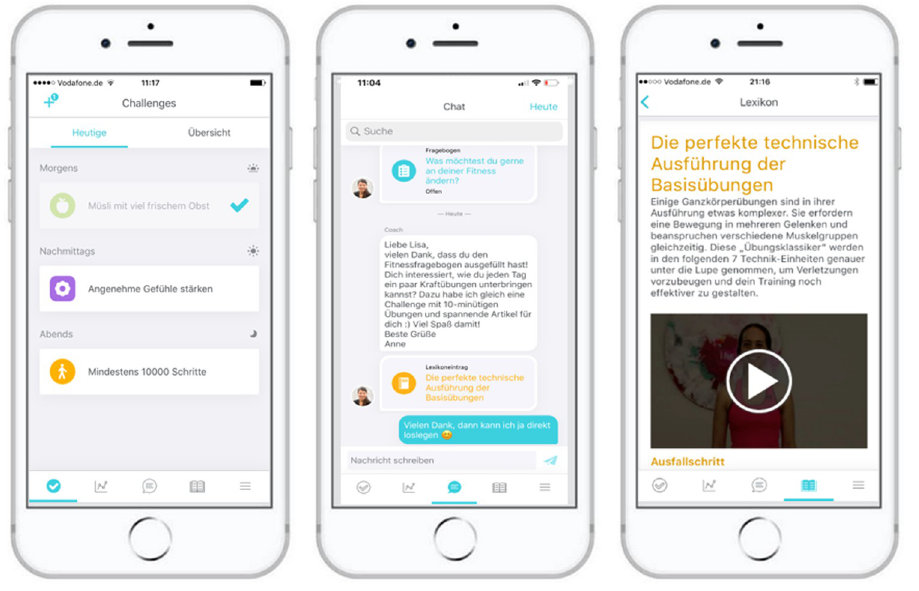
Fig 2. Participant flow chart for the Test TRIANGLE